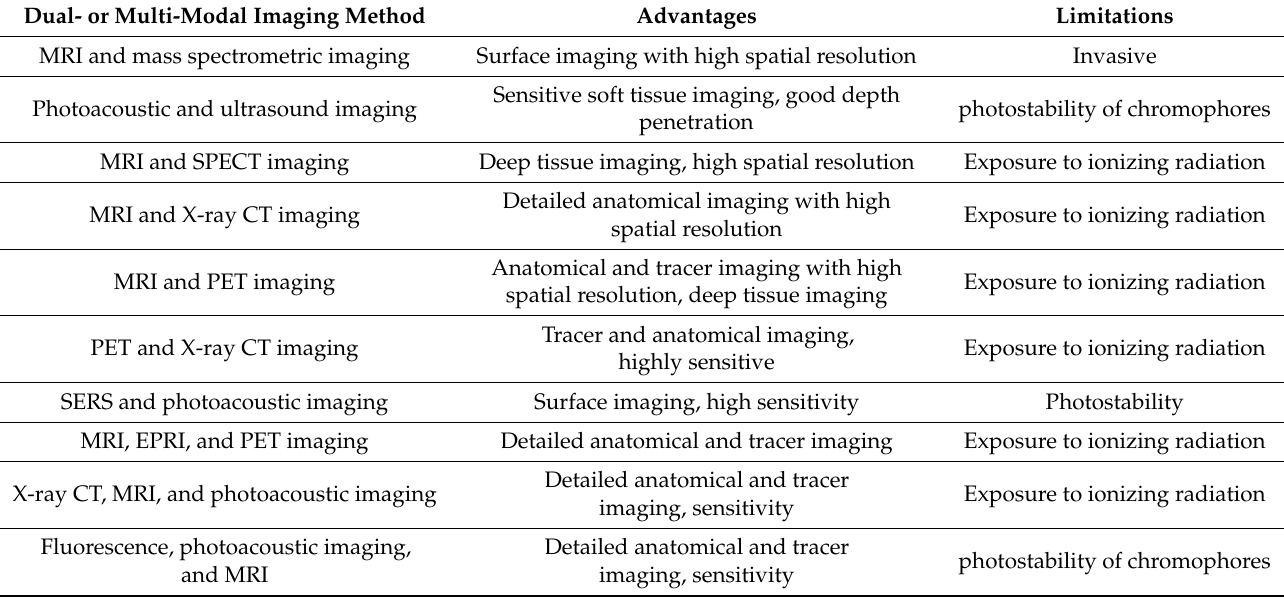
Table 3. Summary of imaging hypoxia with multiple probes and multiple